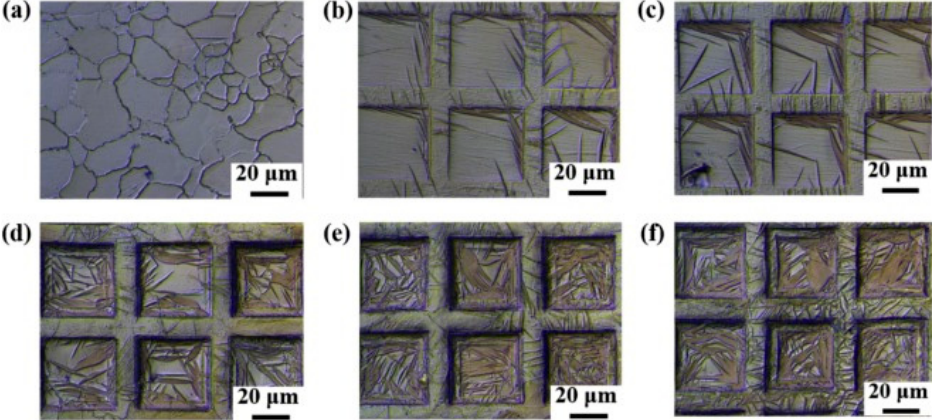
Figure 22. OM showing the microstructure of direct-LSSP-patterned AZ31B with laser intensities of: ( a ) 0; ( b ) 1.18; ( c ) 1.47; ( d ) 1.70; ( e ) 1.92; and ( f ) 2.12 GW/cm 2 . Reproduced with